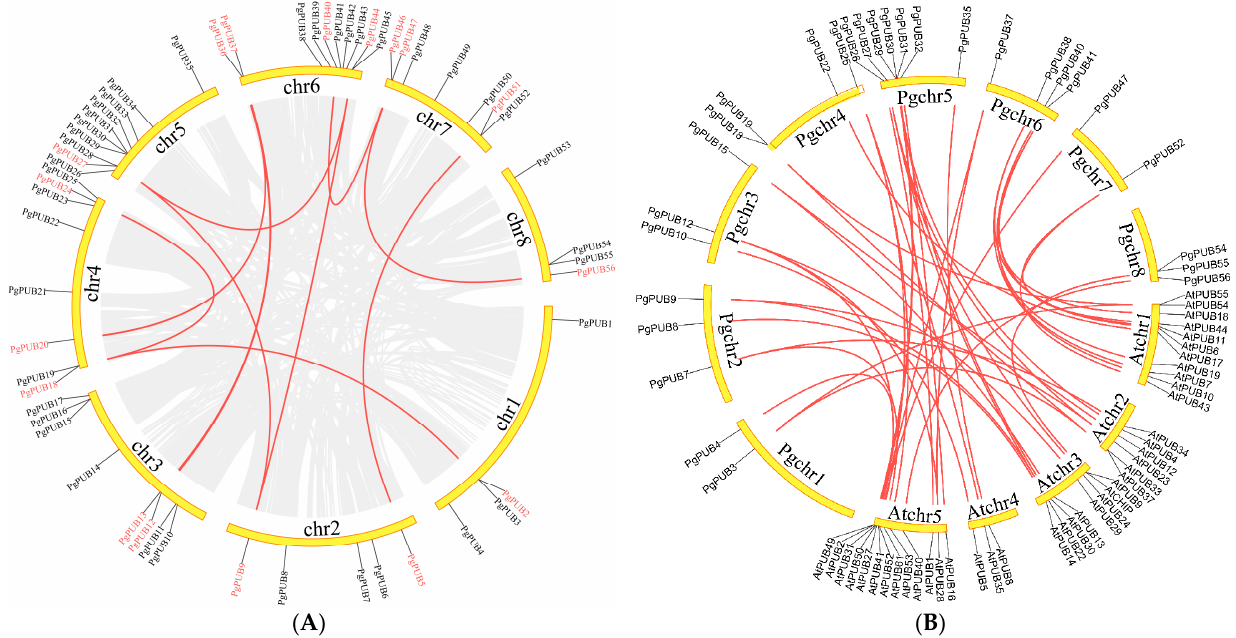
Figure 4. Visualization of collinear U-box gene family. ( A ) Schematic representations for the chro- mosomal localization and interchromosomal relationships of pomegranate U-box genes. The red curve line indicates the U-box gene replications, with the gene name in red color and the gray curve lines indicate the collinear blocks among different chromosomes of pomegranate. ( B ) Synteny analysis of U-box genes between pomegranate and A. thaliana. The red lines highlight the syntenic U-box gene pairs between pomegranate and arabidopsis, with Pgchr and Atchr representing the chromosomes of pomegranate and